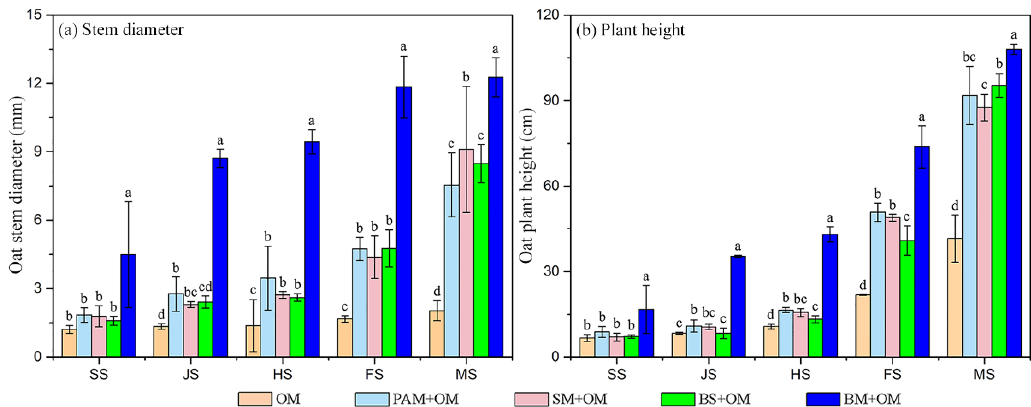
Figure 5. Dynamics of oat stem diameter ( a ) and plant height ( b ) under different growth stages. SS: seedling stage; JS: jointing stage; HS: heading stage; FS: filling stage; MS: maturation stage. Values are means of three replicates ± SD; error bars refer to standard deviation; values having different lowercase letters on the bars indicate significant differences among different treatments (LSD, p < 0.05).